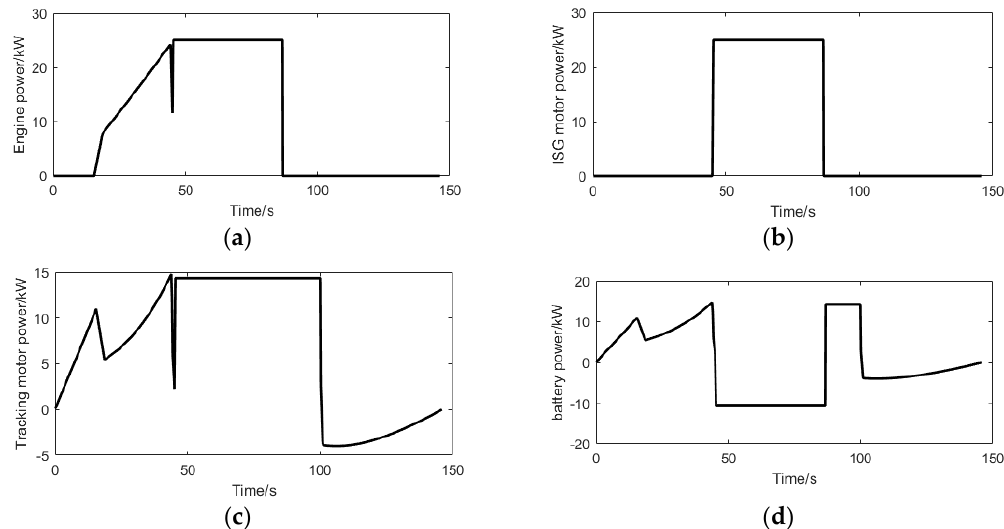
Figure 12. Power of dynamic system components: ( a ) Engine, ( b ) ISG motor, ( c ) Tracking motor, ( d ) Battery. Table 3. Comparison of optimization results between DP and RPKM.